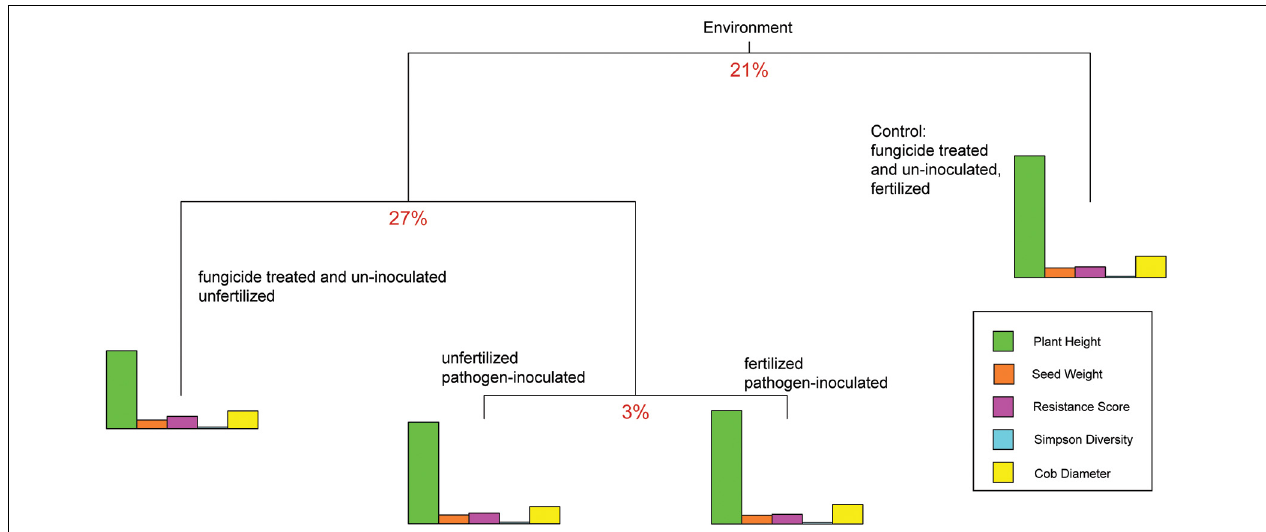
FIGURE 3 | Multivariate partition results for plant traits. The partition explaining the most multivariate variance is at the top of the branch diagram, with each subsequent split dividing the remaining variation. The splitting variables are grouped together to start (as “environment”) then split by stress